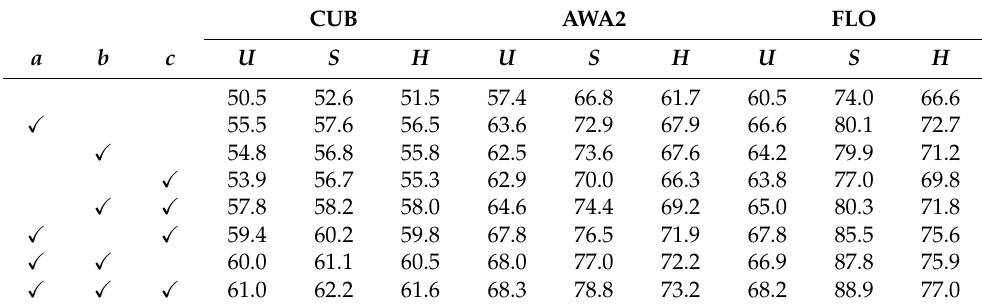
Table 3. Results of ablation study: usage of (a) real seen classes to synthesize residual features; (b) a multi-headed MLP to synthesize the prototype; and (c) smooth L1 loss. CUB